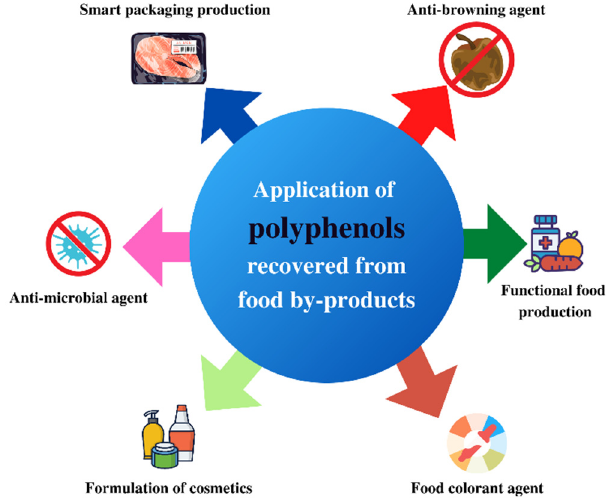
Figure 1. Industrial applications of polyphenols.